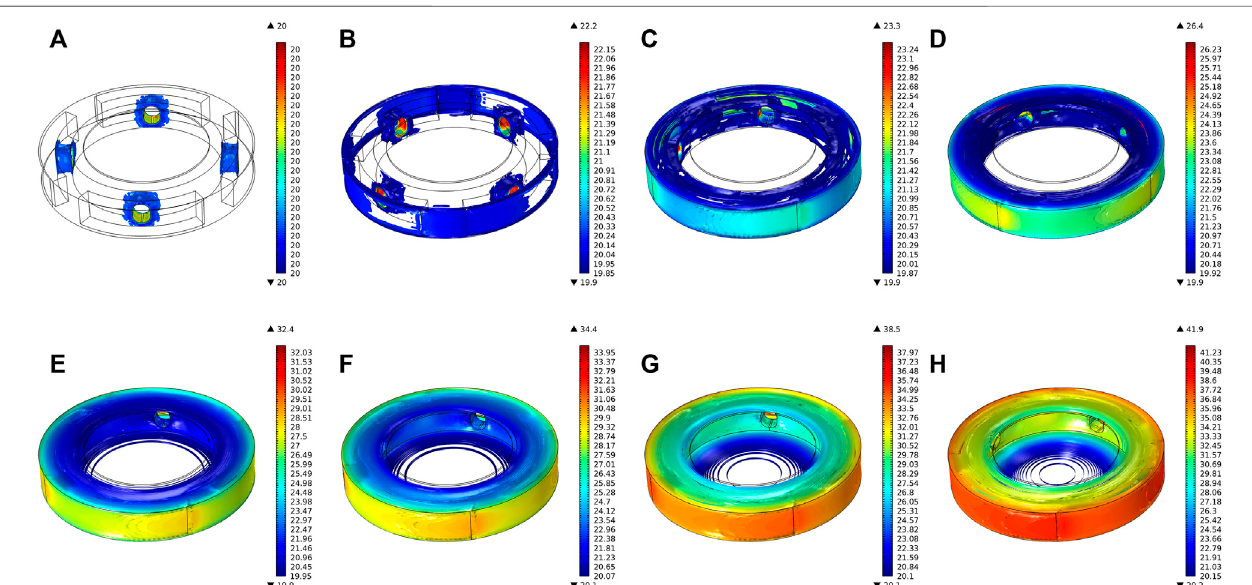
FIGURE 11 | Transient temperature distribution of MRG torsional vibration damper for each moment of working condition Ⅱ : (A) t = 0 s, (B) t = 0.4 s, (C) t = 0.8 s, (D) t = 1.5 s, (E) t = 3 s, (F) t = 4 s, (G) t = 7 s, and (H) t = 10 s.